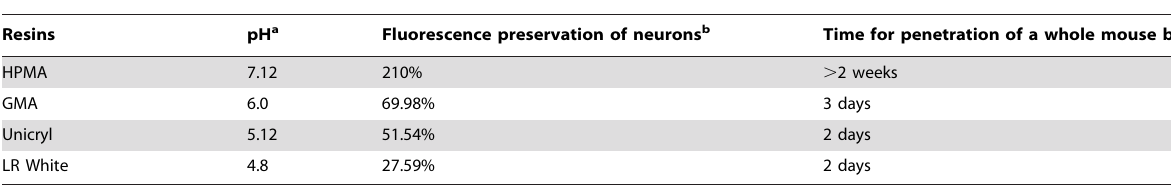
Table 2. Comparison of fluorescence preservation and penetration ability of four resins.